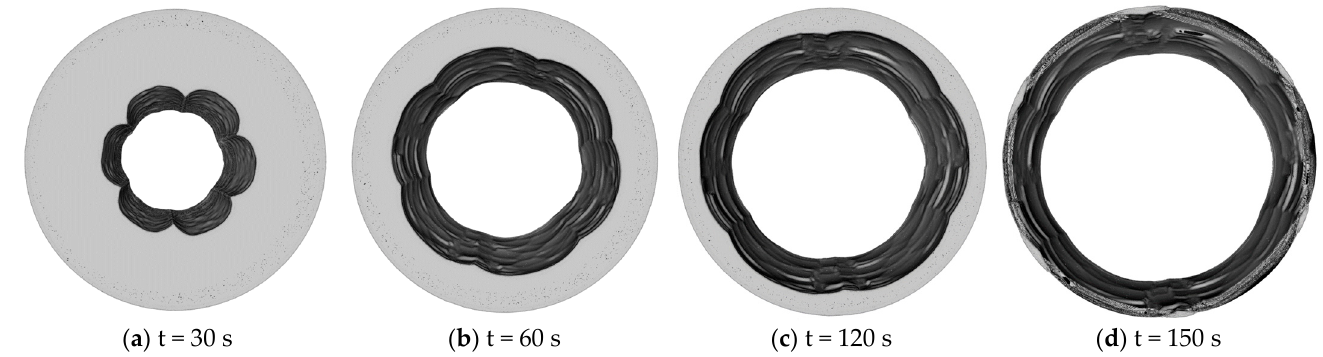
Figure 8. Burning process of NAWC No. 6 partial grain.